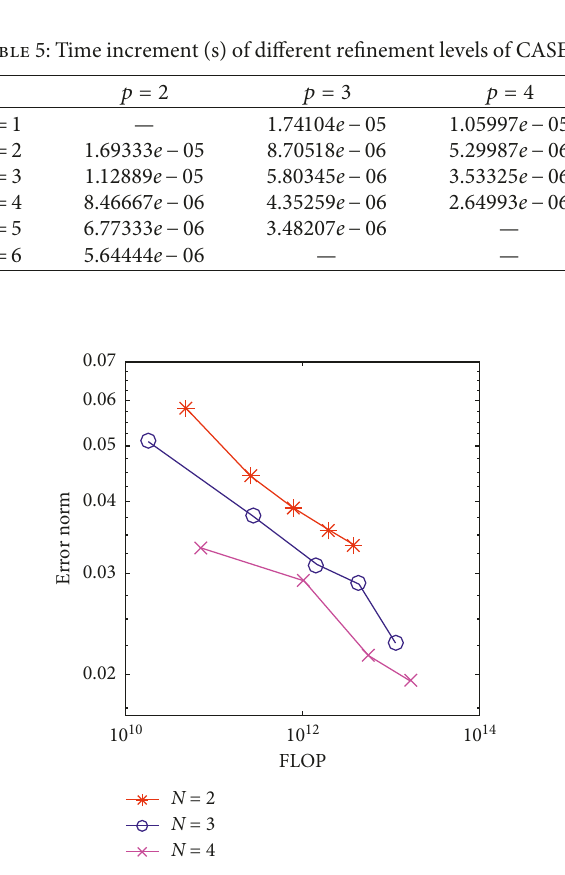
Figure 13: Operation count comparison for different high-order